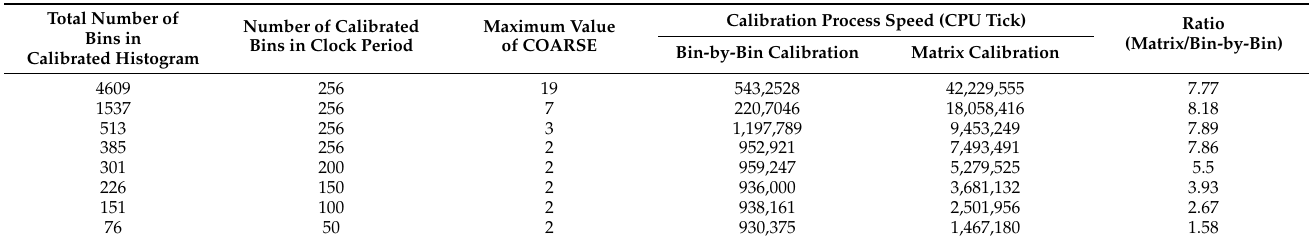
Table 3. Calibration processing speed comparison between the bin-by-bin method for asynchronous TDCs and the matrix